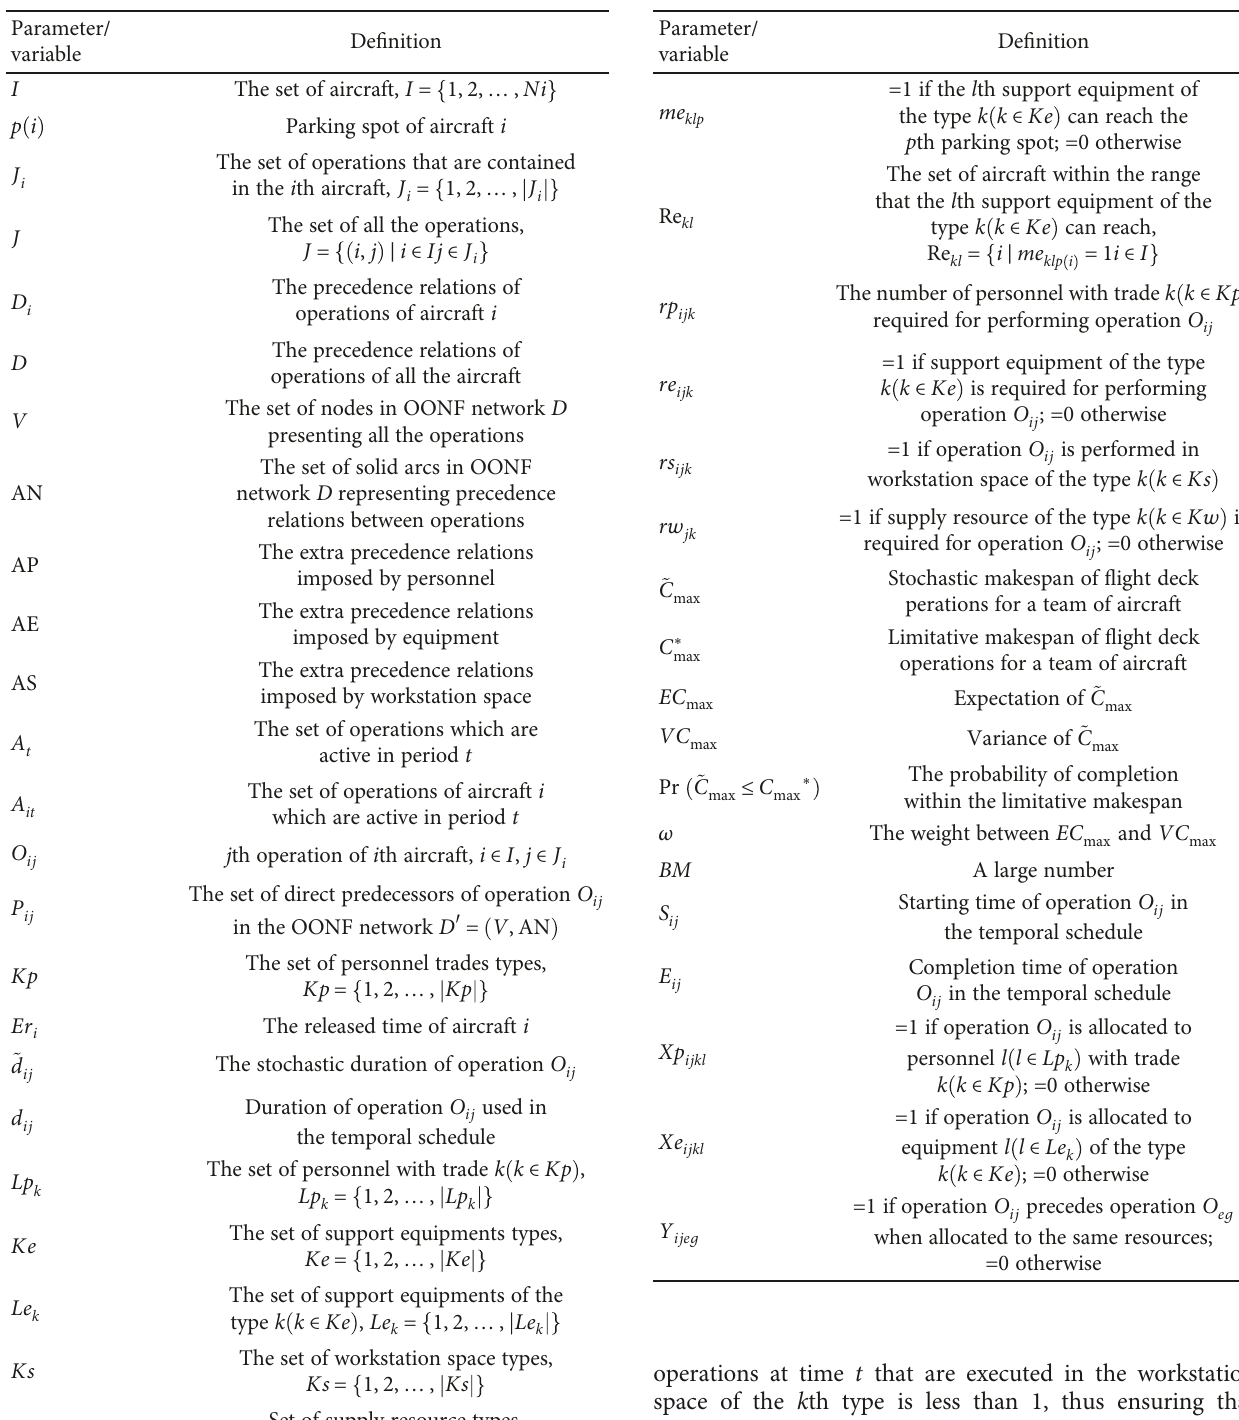
Table 2: Notation for model